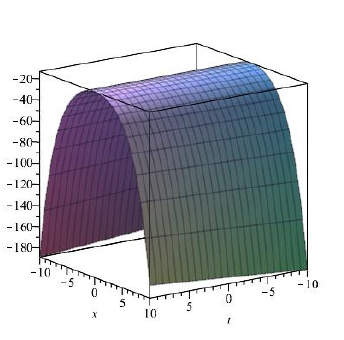
(3.14) also contains arbitrary constants C 2 , C 3 , C 4 , (cid:15) leading to infinite possible solutions. The graphical representations are shown by considering a possibility of these constants. Figures 3 and 4 depict the 3D graphs of solution (3.14) of (1.4) by considering C 2 = 0 , C 3 = − 13 , C 4 = 1 , (cid:15) = 1 and positive sign for 100 angle. The relation of solutions u ( x, t ) and w ( x, t ) can also be observed from